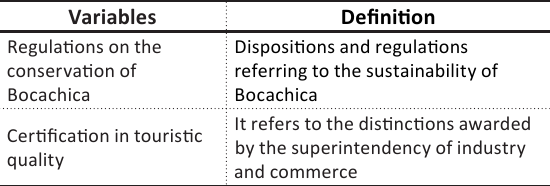
Source: Elaborated by the